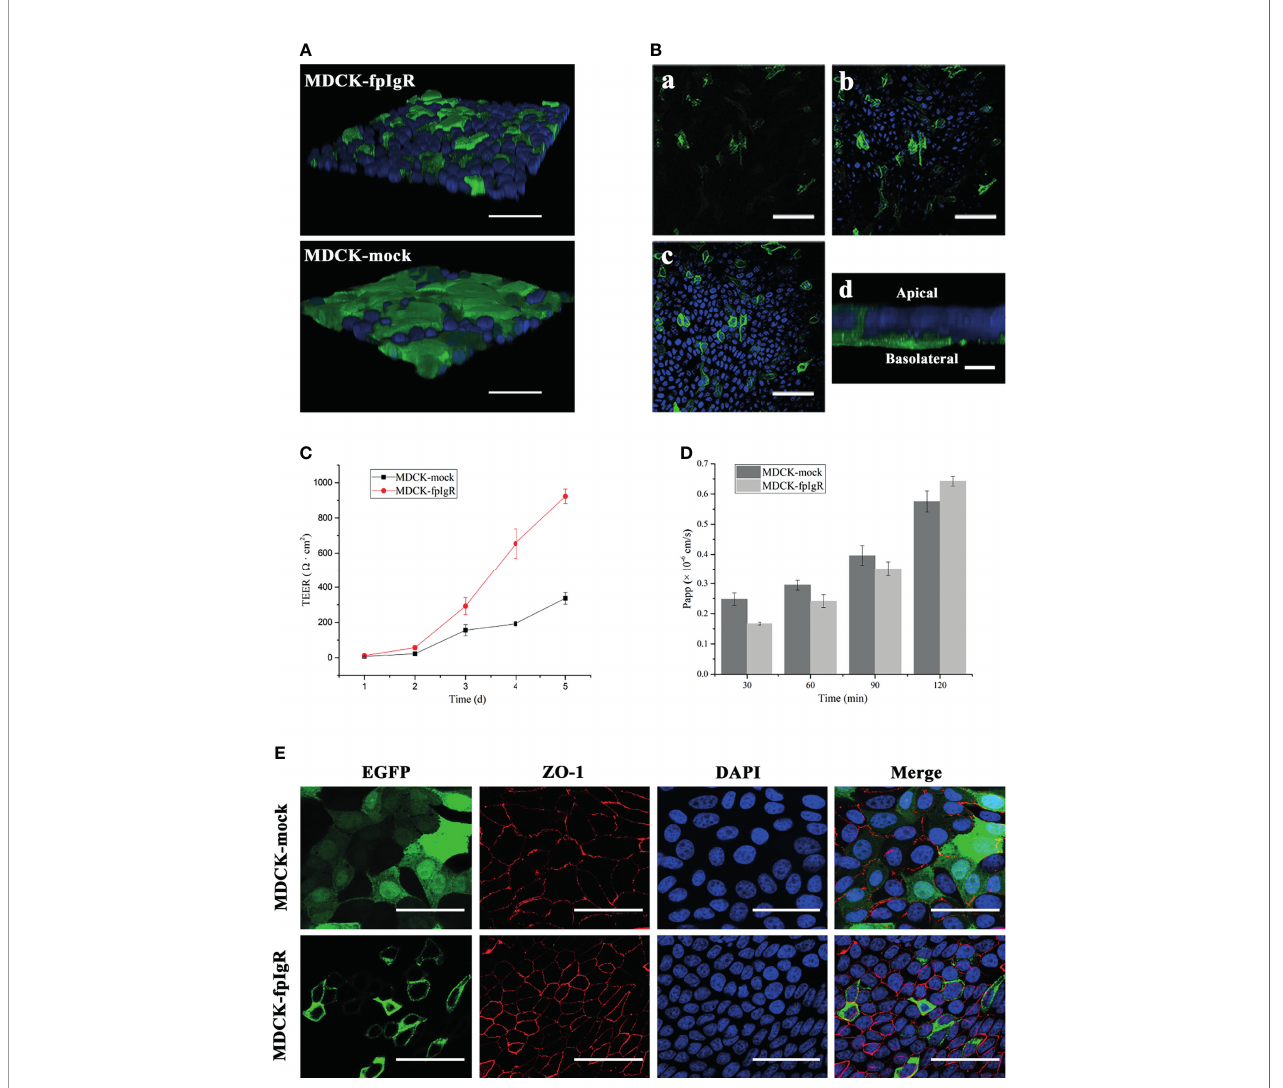
FIGURE 7 | Establishment and evaluation of polarized monolayers of MDCK-fpIgR cells. (A) Detection of monolayers in 3D MDCK-fpIgR and MDCK-mock cells by z -axis CLSM after immuno fl uorescence staining. Bar = 50 µm. (B) fpIgR expression in 3D MDCK-fpIgR cells by z -axis CLSM after immuno fl uorescence staining. (a – c) Micrographs were representative slices of all fl uorescence images. Sections from the basal portion of the cells (a) , the area at the middle and below the nucleus (b) , and at the focal plane (c) are shown. Bar = 50 µm. (d) The fpIgR was detected at the basolateral side of 3D MDCK-fpIgR cells in the z -axis; bar = 10 µm. (C) TEER results of polarized monolayer cells seeded on Transwells for 5 days. Results were the mean ± SD ( n ≥ 3). (D) Apparent permeability of Lucifer yellow at different times. Results were the mean ± SD ( n ≥ 3). (E) Indirect immuno fl uorescence of polarized monolayer cells grown on Transwells. Rabbit anti- ZO-1 polyclonal antibody served as the primary antibody. Bar = 50